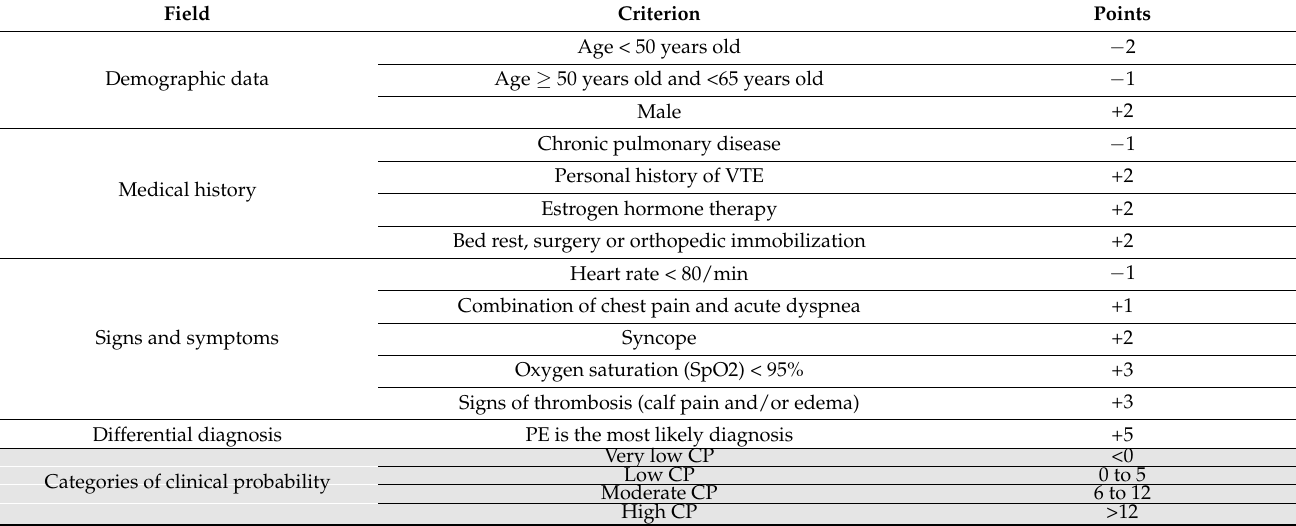
Table 2. 4PEPS or 4-Level Pulmonary Embolism Clinical Probability